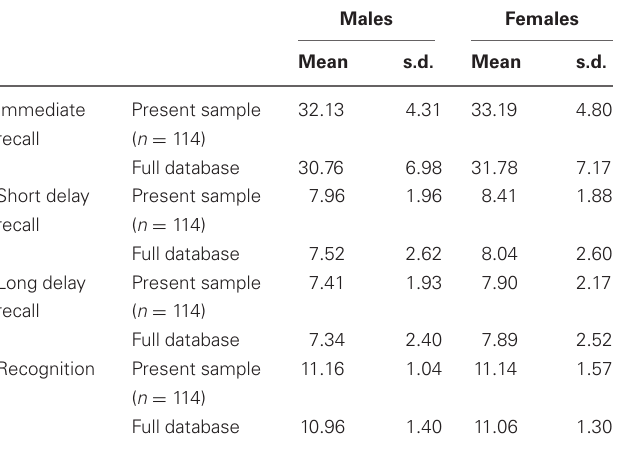
Table 3 | Memory task performance in the present sample relative to the full